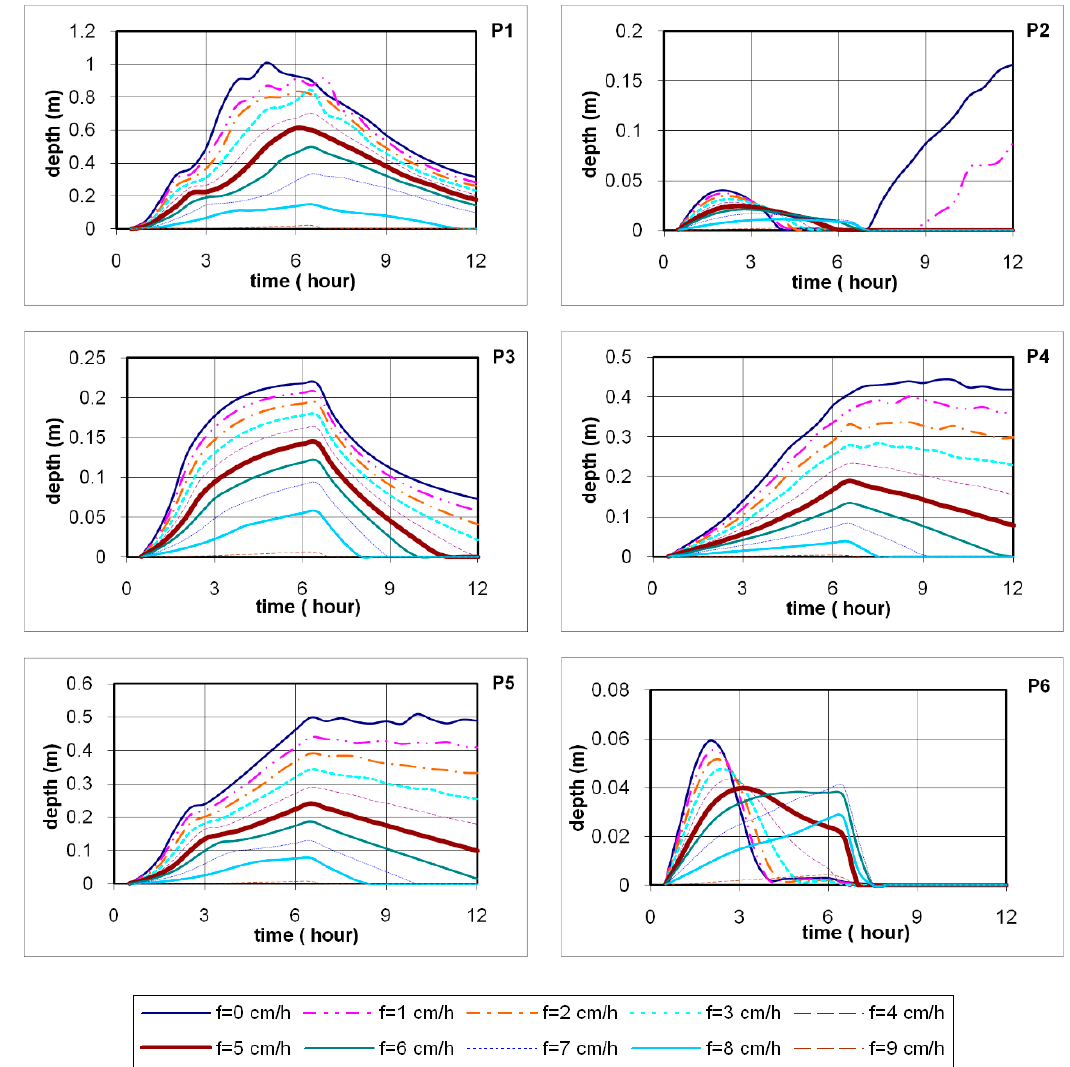
Figure 11. E ff ects of di ff erent infiltration rates on flood depths for the pixels Figure 11. Effects of different infiltration rates on flood depths for the pixels P1–P6.